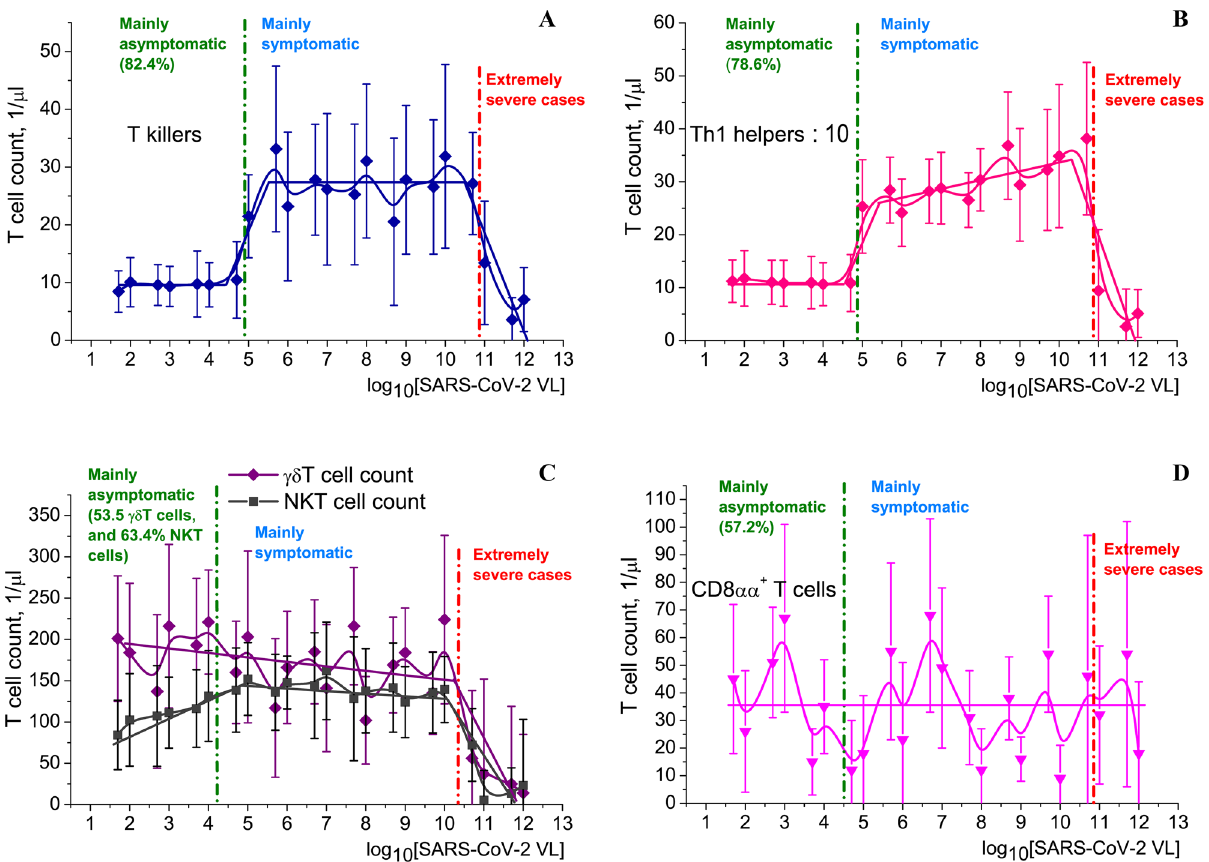
Figure 5. T cell count dependence on logarithm of SARS-CoV-2 VL. Piecewise and smooth approximations are shown. Green dash-dotted line stands for the conditional border between asymptomatic carriers and symptomatic patients. Red dash-dotted line stands for the conditional border between extremely severe clinical cases and the rest of the patients. Percentage numbers in parentheses (green) correspond to the proportion of asymptomatic carriers whose manifestations fit into the conditional range to the left of the green line. ( A ) T killer (CD8 + cytotoxic lymphocyte) count (in serum) dependency on log 10 VL. ( B ) Th1 helper (CD4 + CD94 + lymphocyte) count (in serum) dependency on log 10 VL. ( C ) γδT and NKT lymphocyte counts (in serum) dependency on log 10 VL. ( D ) CD8αα + lymphocyte count (in pharynx MALT analysed in nasopharyngeal or oropharyngeal swabs) dependency on log 10 VL. Created in OriginPro ver. 9.2.196, https:// www. origi nlab.